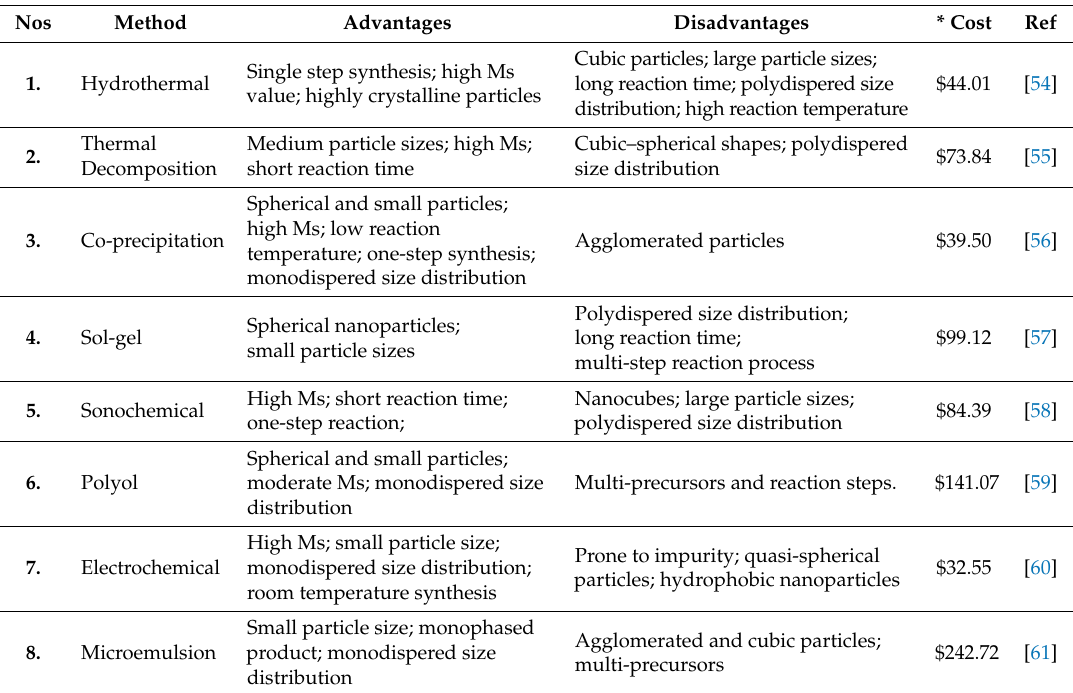
Table 1. Comparative analysis of preparation methods for magnetite